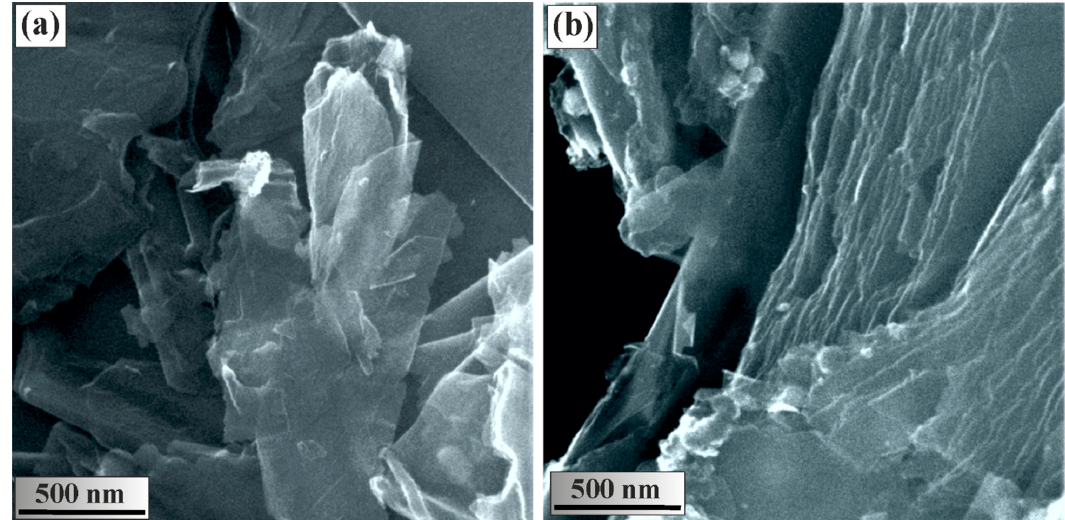
Figure 3. SEM images of the prepared graphene samples: ( a ) sample A, synthesized at 40 A current with pure Ar gas; and ( b ) sample B, fabricated by using a mixture of Ar and N 2 .